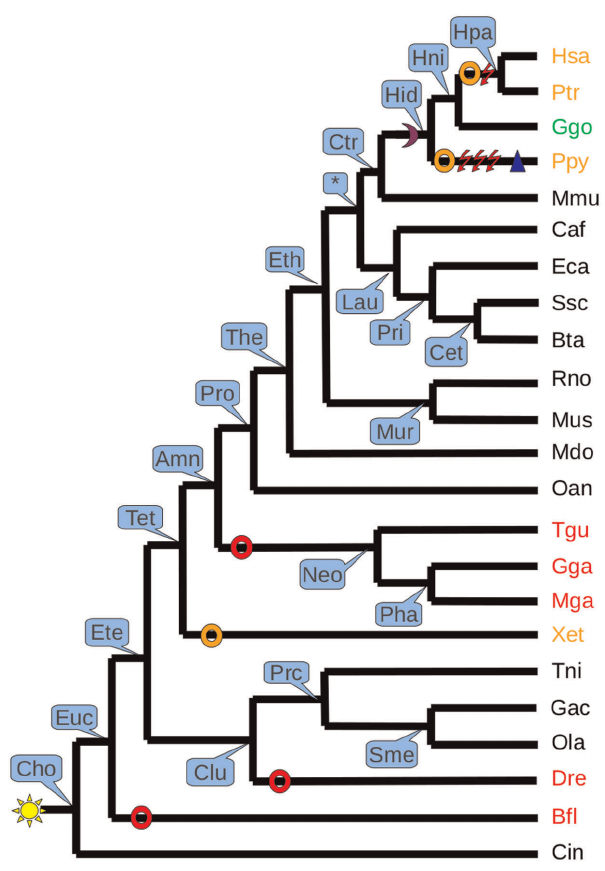
Figure 6. Summary of events occurred during evolution of Acyl3 in 23 species. Each ancestor is indicated in blue frame by their abbreviation. All events are pinpointed on the specific branches. The asterisk indicates ancestor subject of controversy. Red rings show loss events; Orange rings show pseudogenization events; Magenta moon is a splice site mutation; Red flashes represent nonsense codon appearance; Blue triangle is insertion. The yellow star is the point of gene appearance in the phylogenetic tree. The species in red are species that have lost the gene. The species in orange have an orthologous sequence considered as pseudogene, and species in green is species where the recovered gene is considered as potentially intact. The complete name of species and ancestors are described in